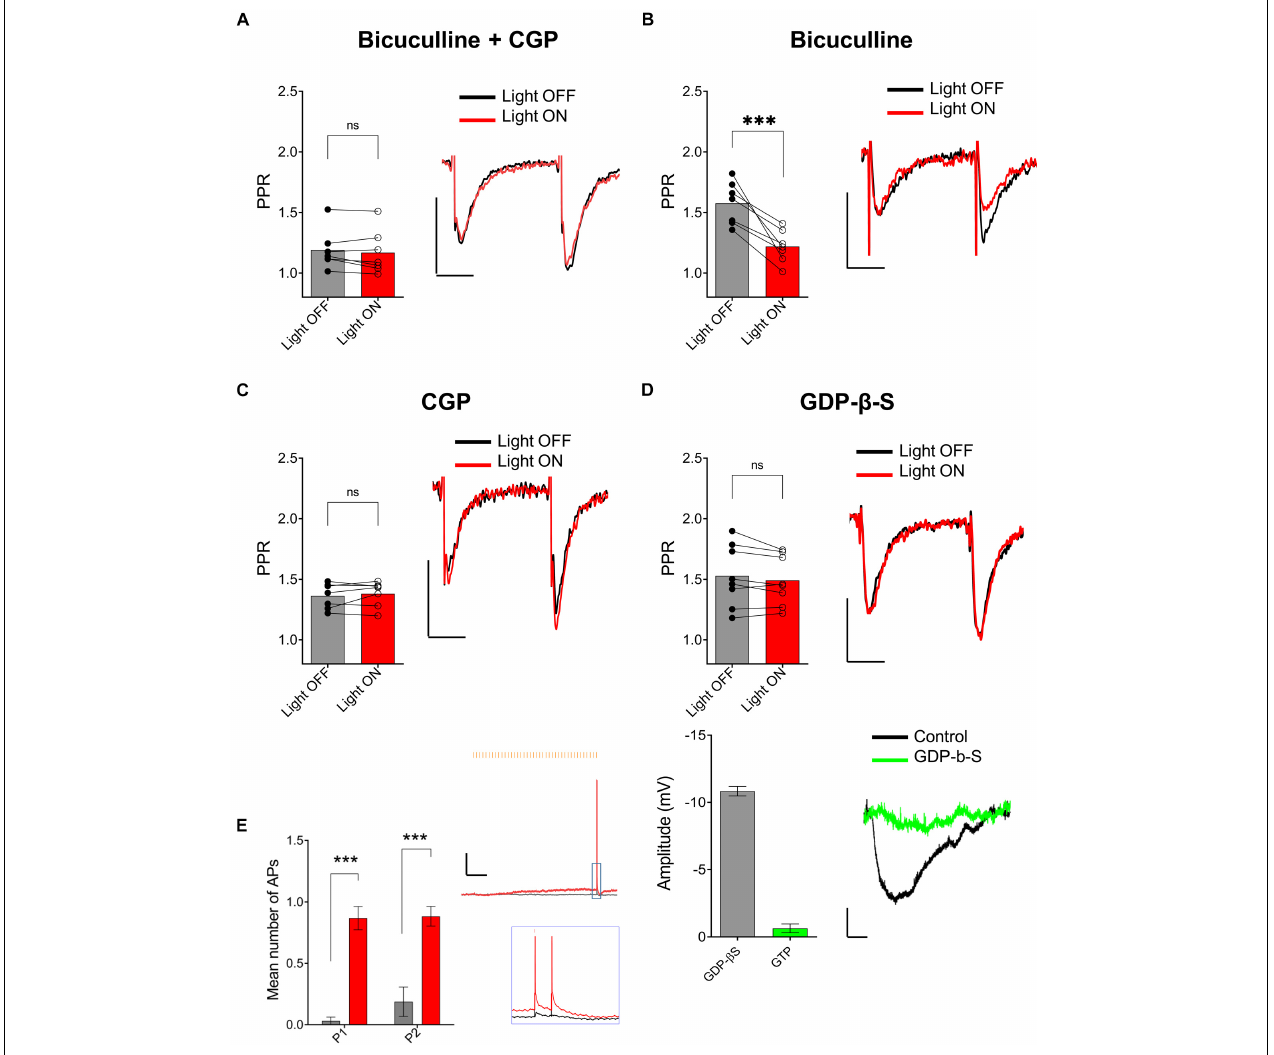
FIGURE 5 | ACh-mediated inhibition of SC inputs required activation of postsynaptic GABA B receptors. (A) Bar plot (left) and representative EPSCs (right) showing ACh-mediated inhibition of SC EPSCs was prevented by GABA A antagonist bicuculline (BIC) and GABA B antagonist CGP 52432 (paired t -test; p = 0.2440); (B) Bar plot (left) and representative EPSCs (right) showing BIC alone had no effect on ACh-mediated inhibition of SC EPSCs (paired t -test; p = 0.8332); (C) Bar plot (left) and representative EPSCs (right) showing ACh-mediated inhibition of SC EPSCs was blocked by bath application of CGP 52432 alone (paired t -test; p = 0.0023); (D) Upper, Bar plot (left) and representative EPSCs (right) demonstrate that inclusion of GDP- β -S in the patch pipette prevented ACh-mediated reduction of SC EPSCs (paired t -test; p = 0.1589). Scale bars: x = 20 ms; y = 50 pA. Lower, Bar plot (left) showing that hyperpolarization produced in CA1 PCs by the GABA B receptor agonist baclofen was prevented when including GDP- β -S in the intracellular solution (green bar). Representative membrane potential responses (Right) to baclofen in PCs recorded with intracellular solution containing GTP (black) or GDP- β -S (green); scale bars: x = 100 s; y = 2 mV. (E) Bar plots (on left) and representative traces (on right) showing that ACh-release increased the probability that CA1 interneurons produced APs in response to the paired electrical impulses delivered to the SR. Inset shows magnified image of traces indicated by the blue box. Black trace: light OFF, Red trace: Light ON; scale bars: x = 1000 ms; y = 5 mV (2-way ANOVA: significant effect of light stimulation; p <